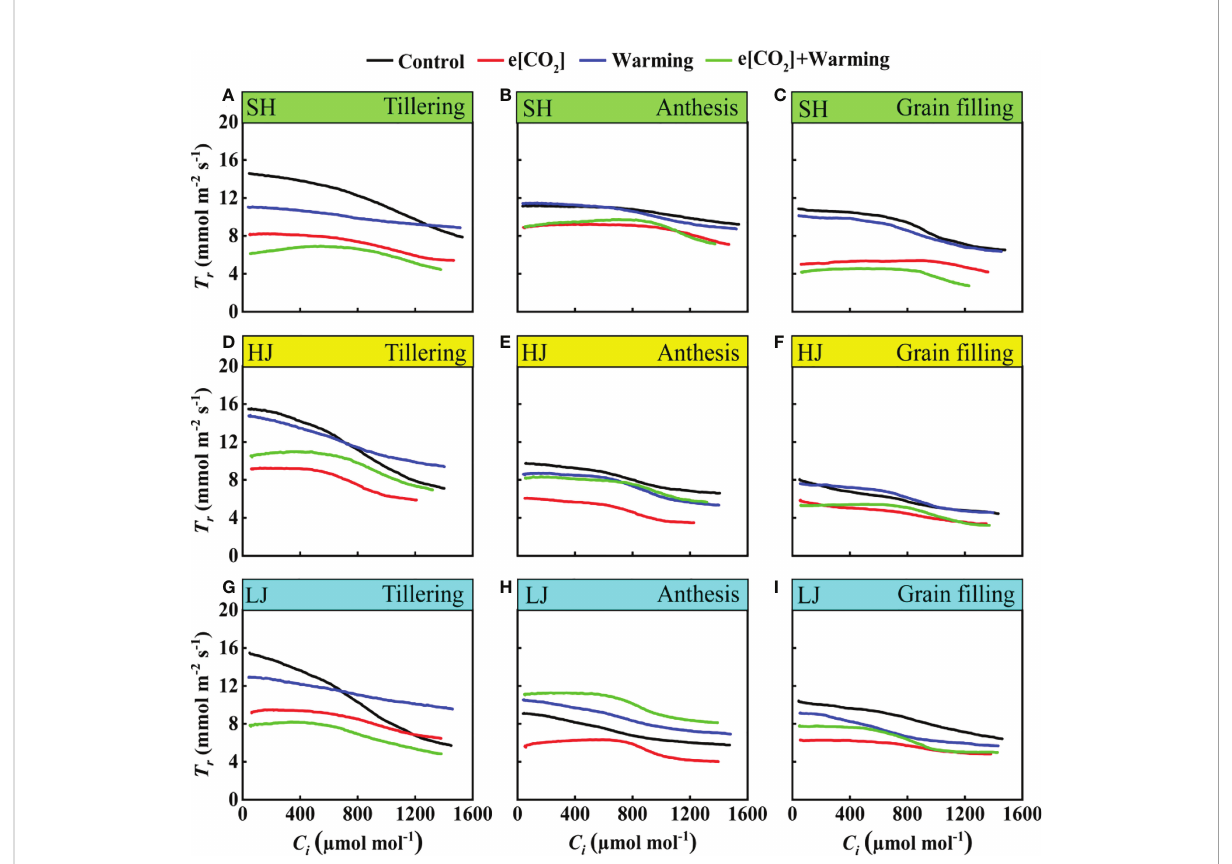
FIGURE 8 The T r - C i curves under ambient CO 2 and temperature (black dots, Control), elevated CO 2 (red dots, e[CO 2 ]), elevated temperature (blue dots, warming), and eCO 2 plus warming (green dot, e[CO 2 ]+warming) for cv. SH ( A-C ), HJ ( D-F ), and LJ ( G-I ) during the tillering stage, anthesis stage, and grain- fi lling stage. T r represents transpiration rate, C i represents intercellular carbon dioxide